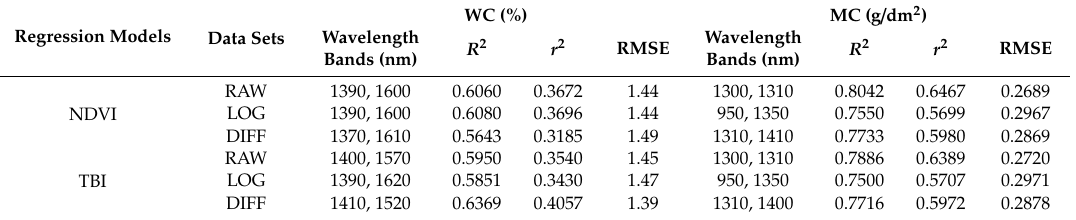
Table 2. Model performance by using NDVI and TBI according to wavelength and water status. Regression